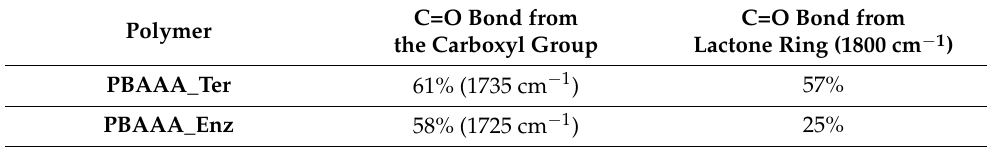
Table 1. Relative contributions (%) of the C=O unit of polymer PBAAA_Ter versus PBAAA_Enz . Polymer the Carboxyl